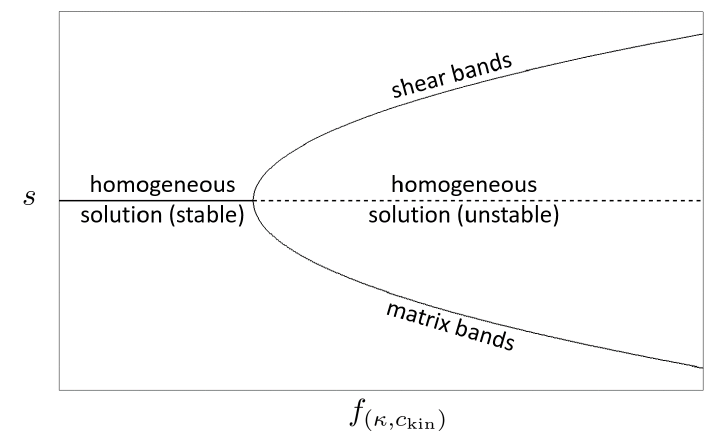
Figure 17. Assumed supercritical pitchfork bifurcation of the effective plastic strain s (cf. Equation (9)) in the parameter space. The control parameter is a function of both parameters of kinematic